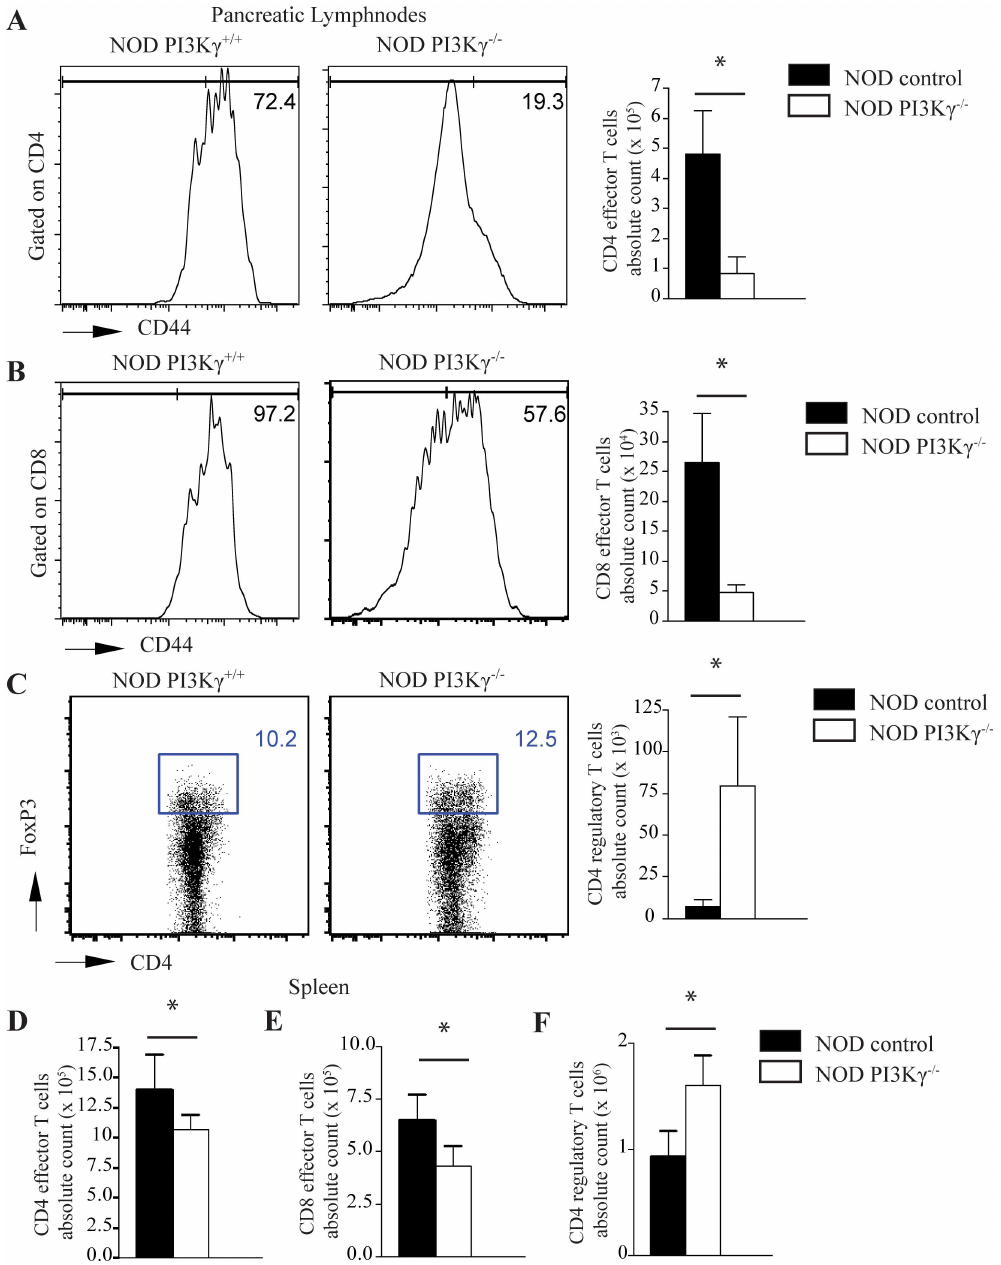
Fig 2. PI3K γ -deficiency restoresthe balance of effector versus regulatory T-cells toward regulatory. (A) Representative exampleof FACS stainingfrom pancreatic lymphnodes of NOD.PI3K γ +/+ and NOD.PI3K γ -/- at 12-weeksof age shows lower percentage of CD4 effector-T-cells (CD4+CD44high)in mice lackingPI3K γ compared to WT-NOD.PI3K γ +/+ mice. Bar graph shows the absolutecount of CD4 effector-T-cells. ( * p < 0.05,n = 4 mice in each group). Results are presentedas the mean ± s.e.m. (B) Representative exampleof FACS stainingfrom pancreaticlymphnodes of NOD.PI3K γ +/+ and NOD.PI3K γ -/- at 12-weeksof age shows lower percentageof CD8 effector-T-cells (CD8+CD44high)in mice lacking PI3K γ comparedto WT-NOD.PI3K γ +/+ . Bar graph shows the absolutecount of CD8 effector-T-cells. ( * p < 0.05,n = 4 mice in each group). Results are presentedas the mean ± s. e.m. (C) Representative example of FACS stainingfrom pancreatic lymphnodes of NOD.PI3K γ +/+ and NOD.PI3K γ -/- at 12-weeksof age shows higherpercentageof CD4 regulatoryT-cells (CD4+FoxP3+) in mice lackingPI3K γ comparedto WT-NOD.PI3K γ +/+ . Bar graph shows the absolute count of CD4 regulatoryT-cells. (D) Bar graph shows the absolute count of CD4 effector-T-cells (CD4+CD44high)in splenocytes of mice lackingPI3K γ compared to WT-NOD.PI3K γ +/+ . (E) Bar graph shows the absolutecount of CD8 effector-T-cells